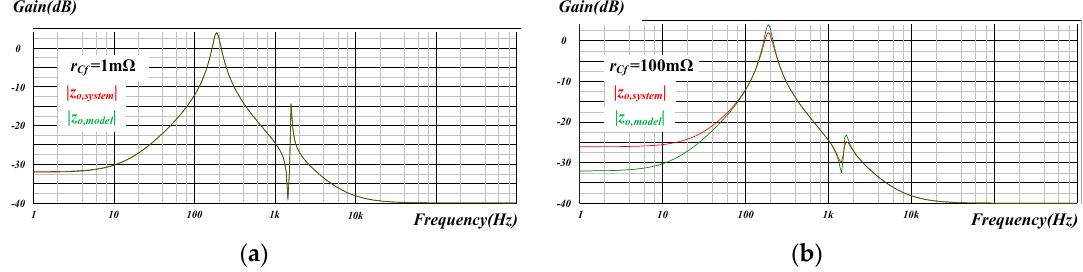
Figure 6. Bode plot of the output impedance of an LC filter in series with Buck: ( a ) r cf = 1 m Ω ; ( b ) r cf = 100 m Ω .